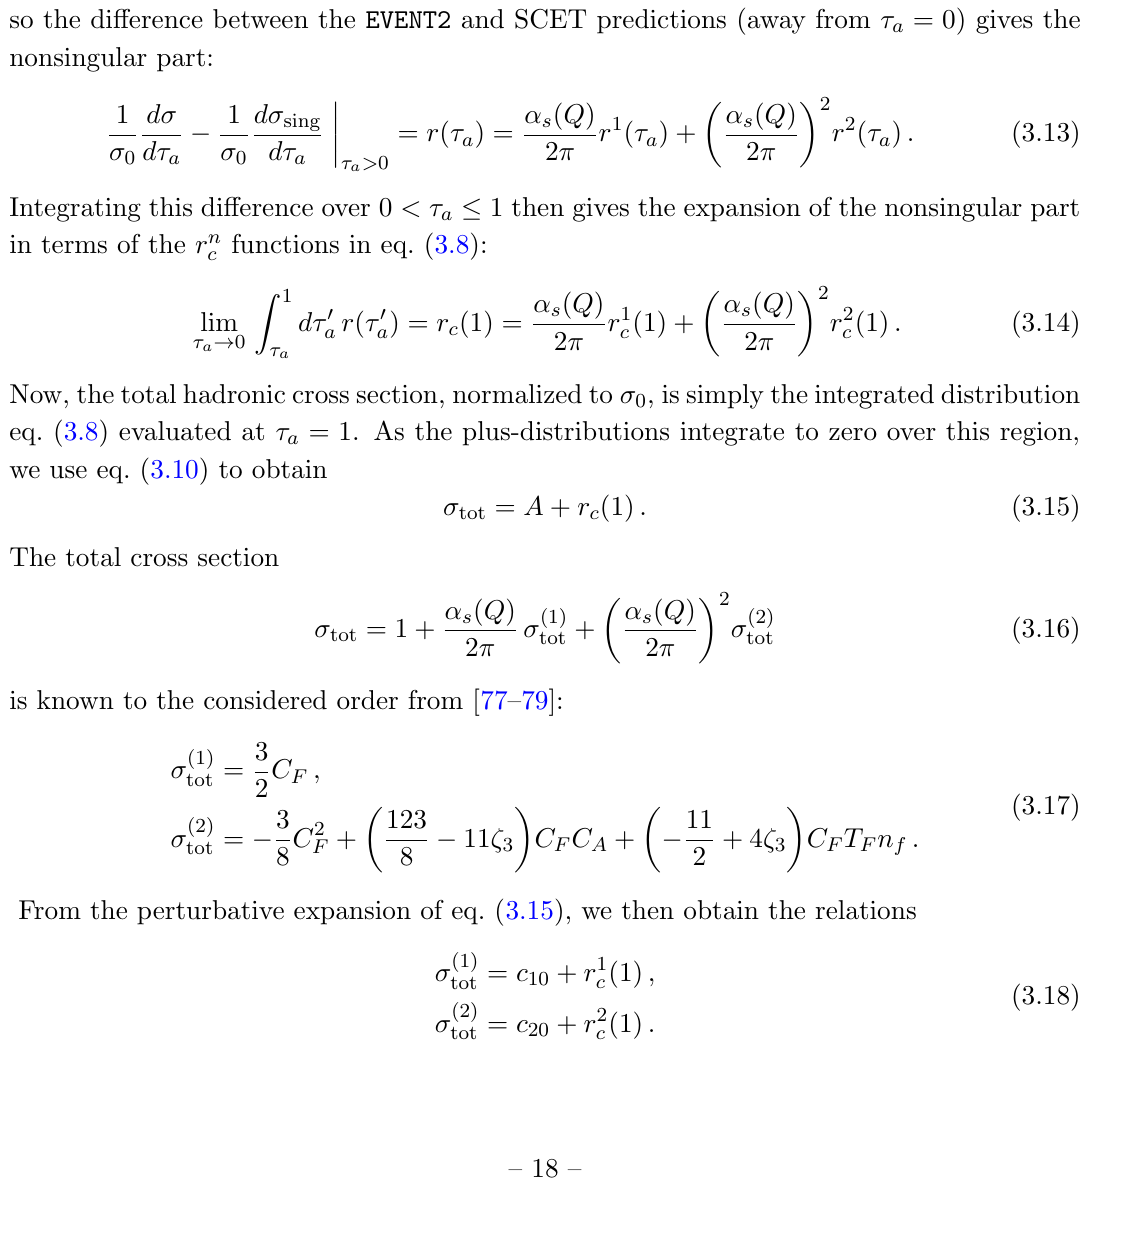
Figure 4 . Integral eq. (3.14) of the lower integration limit (cid:28) a . As (cid:28) a r 1 (1), for the case a = c